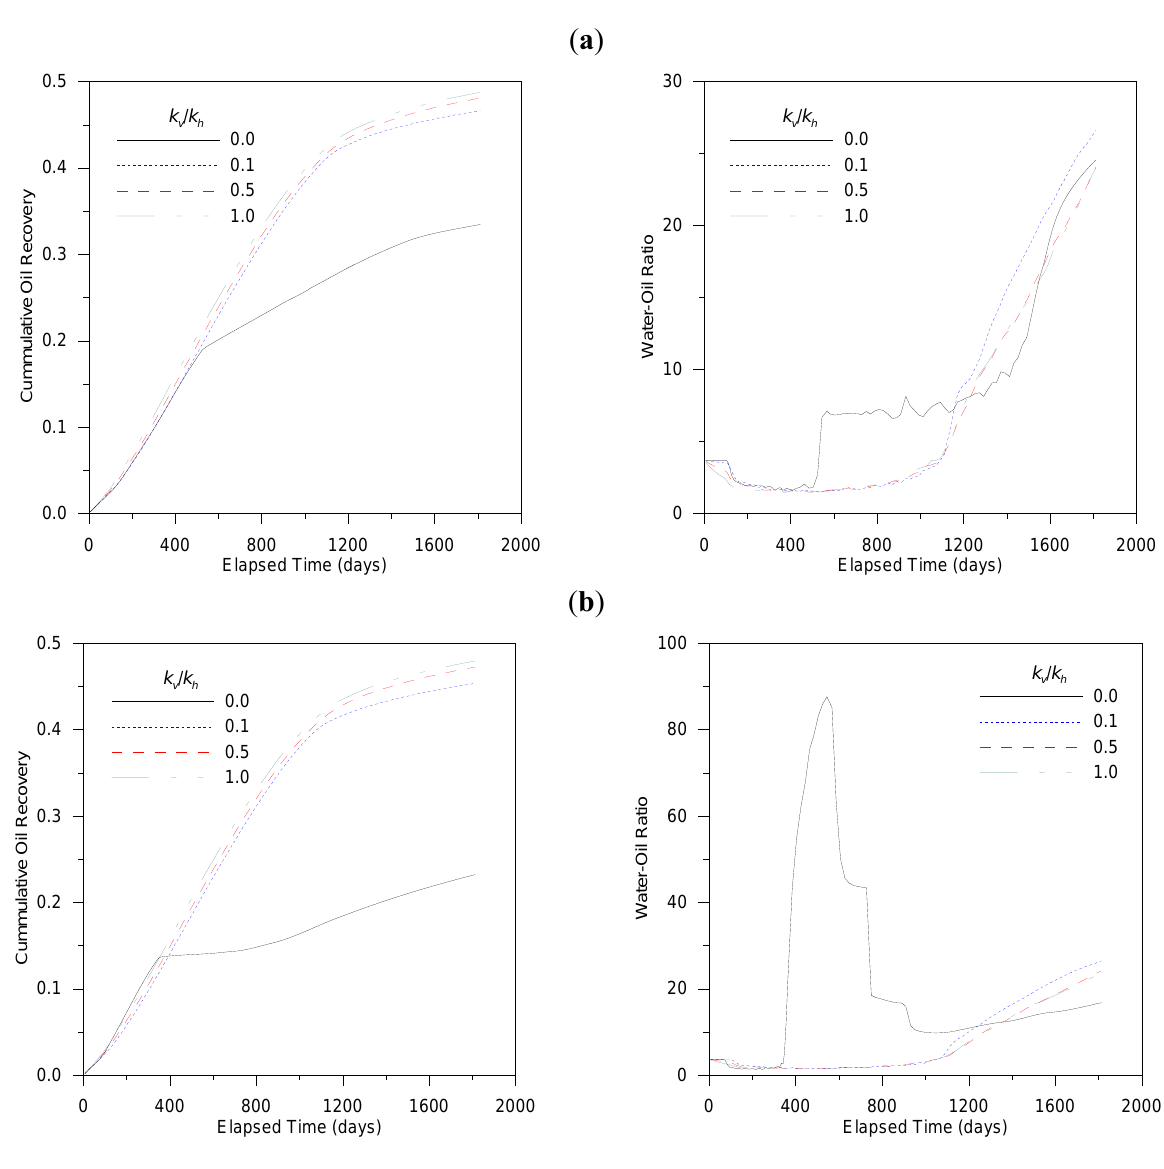
P and kk / . ( a ) 0.1 = P (Newtonian fluid); hv α α ( a